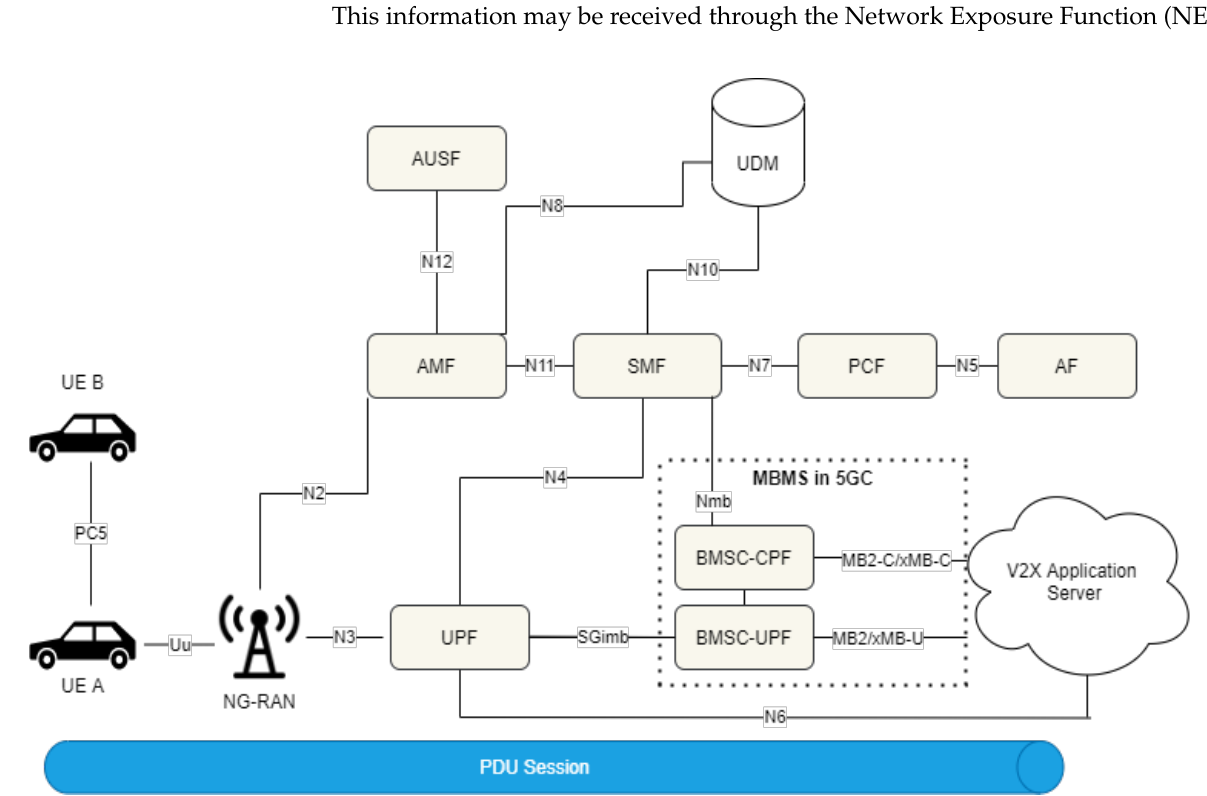
Figure 1. 5G-V2X network architecture described by the 3rd Generation Partnership Project (3GPP) [23,24].